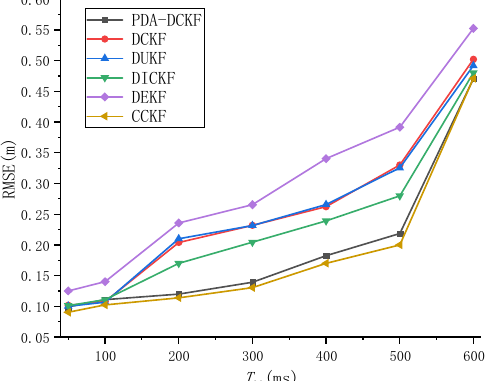
Figure 6. RMSE versus T 60 for different tracking algorithms with SNR = 20 Db.